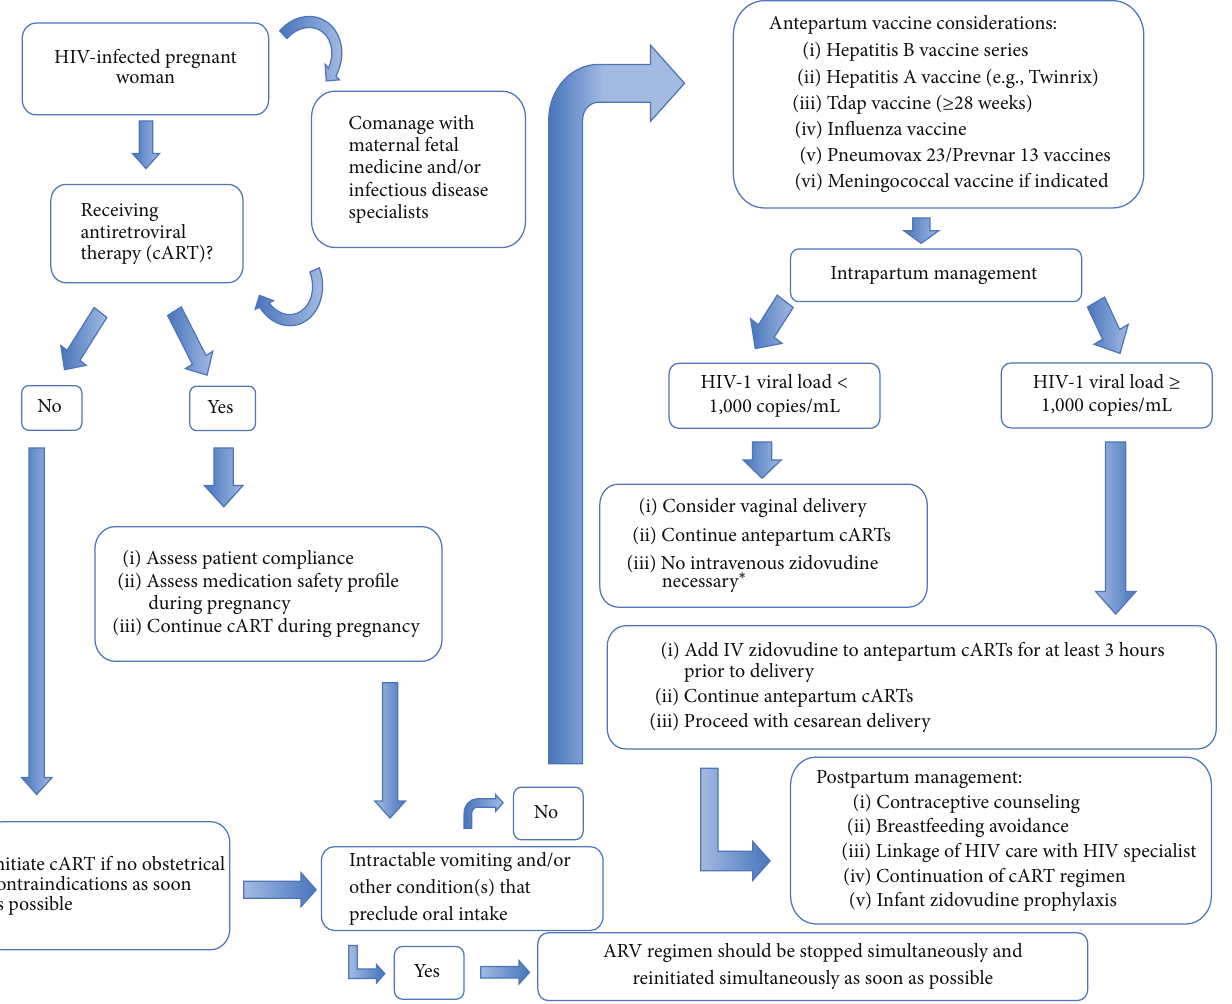
Figure 1: Algorithm for management of HIV during pregnancy. ∗ Intravenous (IV) zidovudine is not required for HIV-infected women who are compliant with cART and who have an HIV-viral load < 1000 copies/mL at the time of delivery. HIV: human immunodeficiency virus, cART: combination antiretroviral therapy, PO: per os (by mouth), CBC: complete blood count, CMP: complete metabolic panel, CD4: cluster of differentiation 4, and mL: